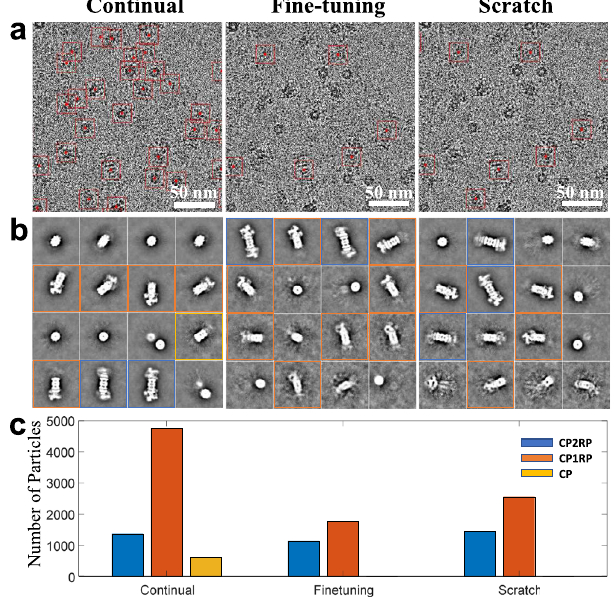
Fig. 4 Comparison of biased and unbiased picking on a 26S proteasome dataset. a The particle picking results (red boxes) of the three models. To improve the visualization, a small region of a typical micrograph is shown. The continual-learning model results in the picking of nearly all particles appearing on the micrograph. The results using the fi ne-tuning and scratch models are more speci fi c on the side-view of CP2RP (a core particle with two regulatory particles) particles and ignore other particles. b Part of the 2D (two-dimensional) class averages with the highest occupancy, which are sorted in descending order of the occupancy. Different border colors specify CP2RP (blue), CP1RP (a core particle with one regulatory particles, orange), and CP (core particle, yellow) particles, respectively. In the results of the fi ne-tuning model, the CP2RP classes have higher occupancy than other particles. c Plot of the total number of particles picked with different models. The three models picked nearly the same number of CP2RP particles (blue bars). The fi ne-tuning and scratch model missed many CP1RP particles (orange bars) and nearly all CP particles (yellow bars), indicating biased